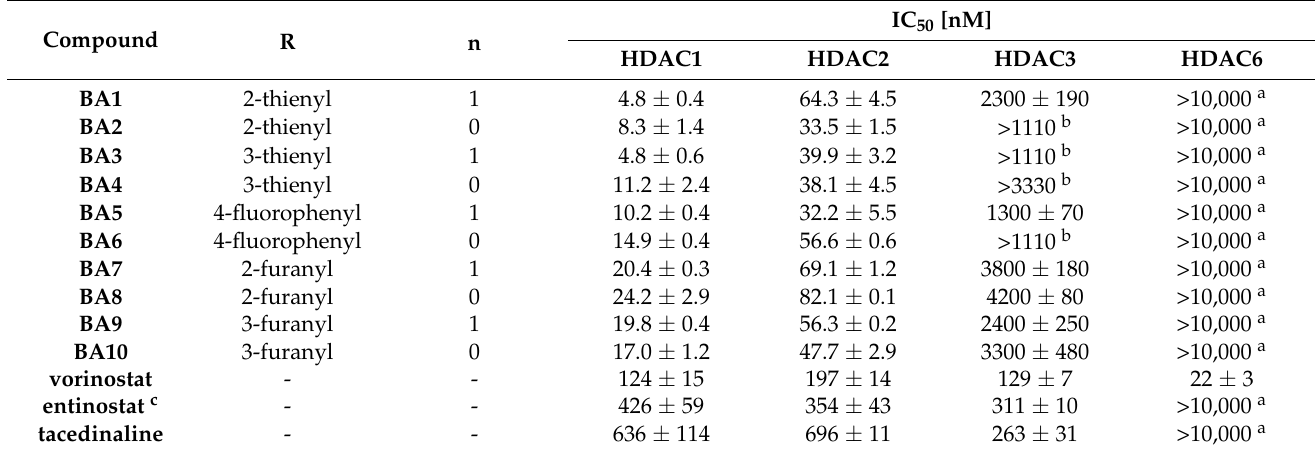
Table 2. Determined inhibitory activities of BA1-BA10 against HDAC1-3 and